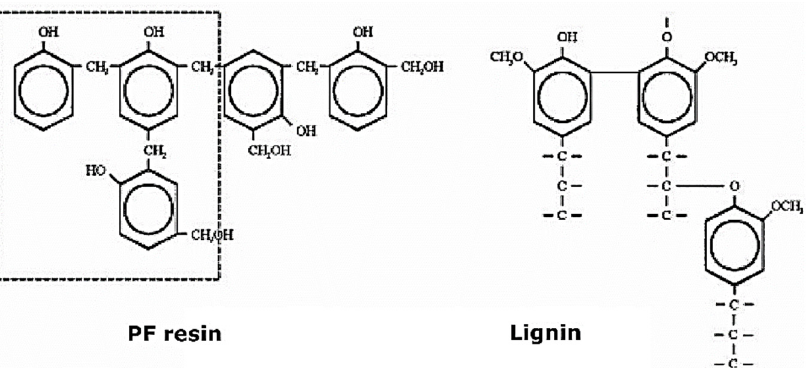
Figure 1. Structure of PF resin and lignin [59].